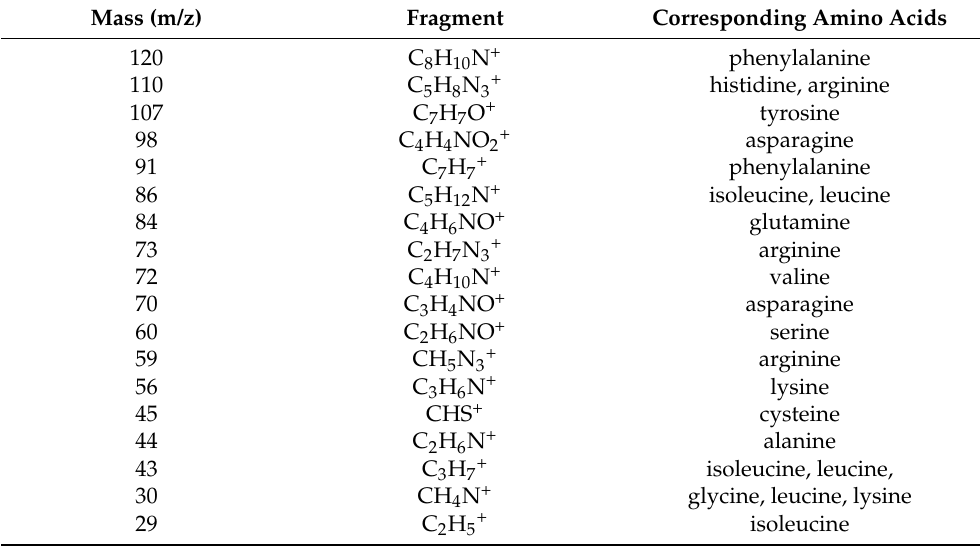
Table 4. Selected positive ion fragments and corresponding amino